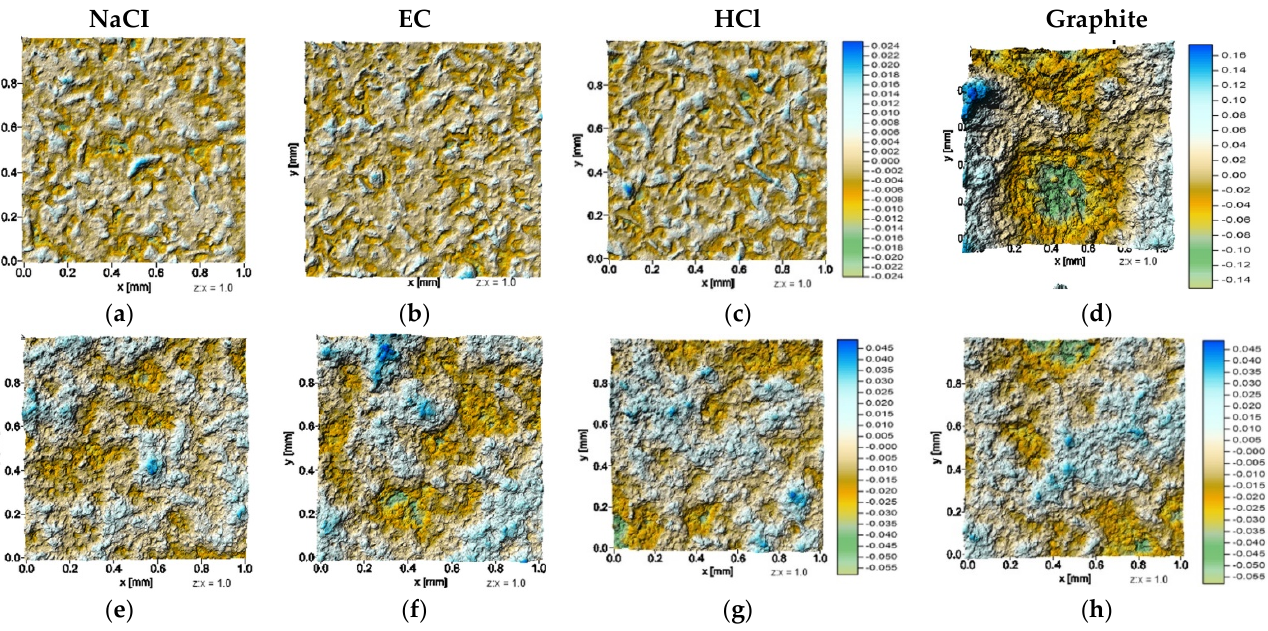
Figure 4. Microtopography of the as-sprayed, free-standing YSZ coatings. The images in the same column belong to the detachment method written on top. The top row ( a – d ) shows the surface of the coatings that was in contact with the substrate and the bottom row ( e – h ) shows the top surface of the coatings.